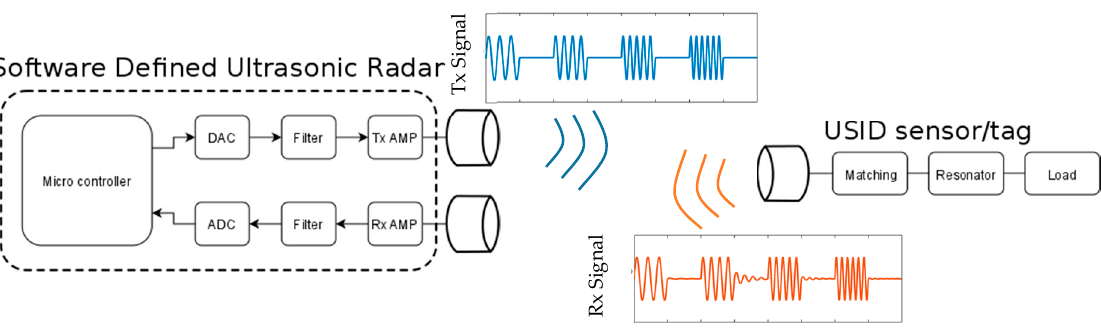
Figure 1. Basic concept of a wireless readout of a resonance frequency using ultrasonic wave propagation.